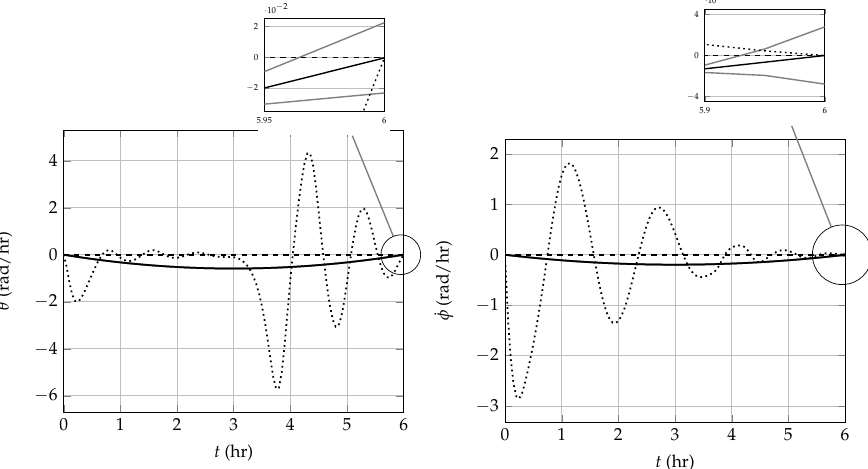
Figure 5. Angular velocity trajectories of the spacecraft. The black curves are the angular velocities of the actual nonlinear system, whereas the gray curves are the angular velocities of the auxiliary linear systems. The dashed line is the desired velocity at final time and the dotted line a solution using a non-convex